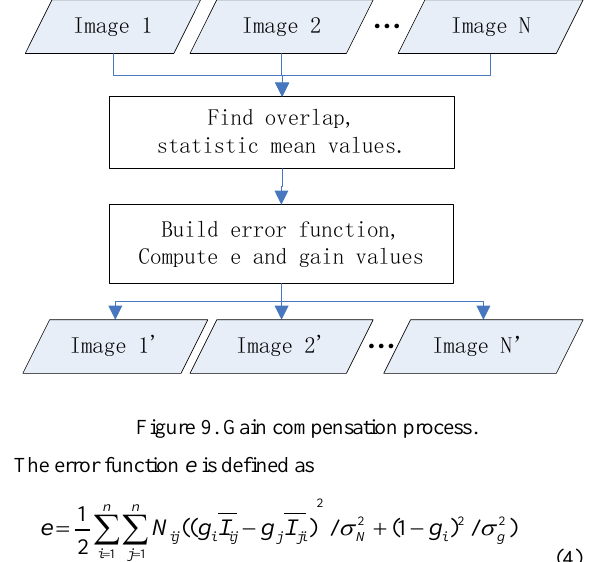
Figure 9. Gain compensation process.